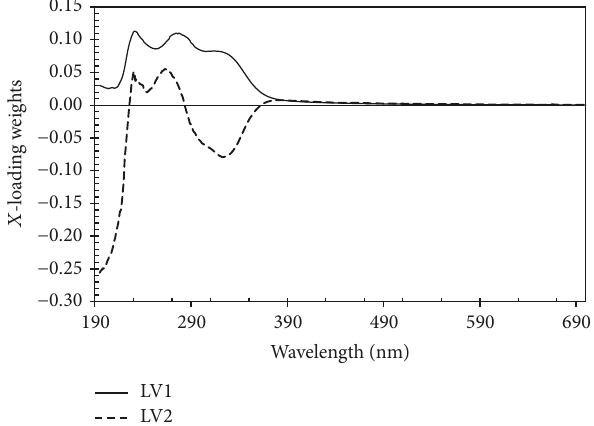
Figure 6: 𝑋 -loading weights versus wavelength of the top two latent variables (LV1 and LV2) of coffee